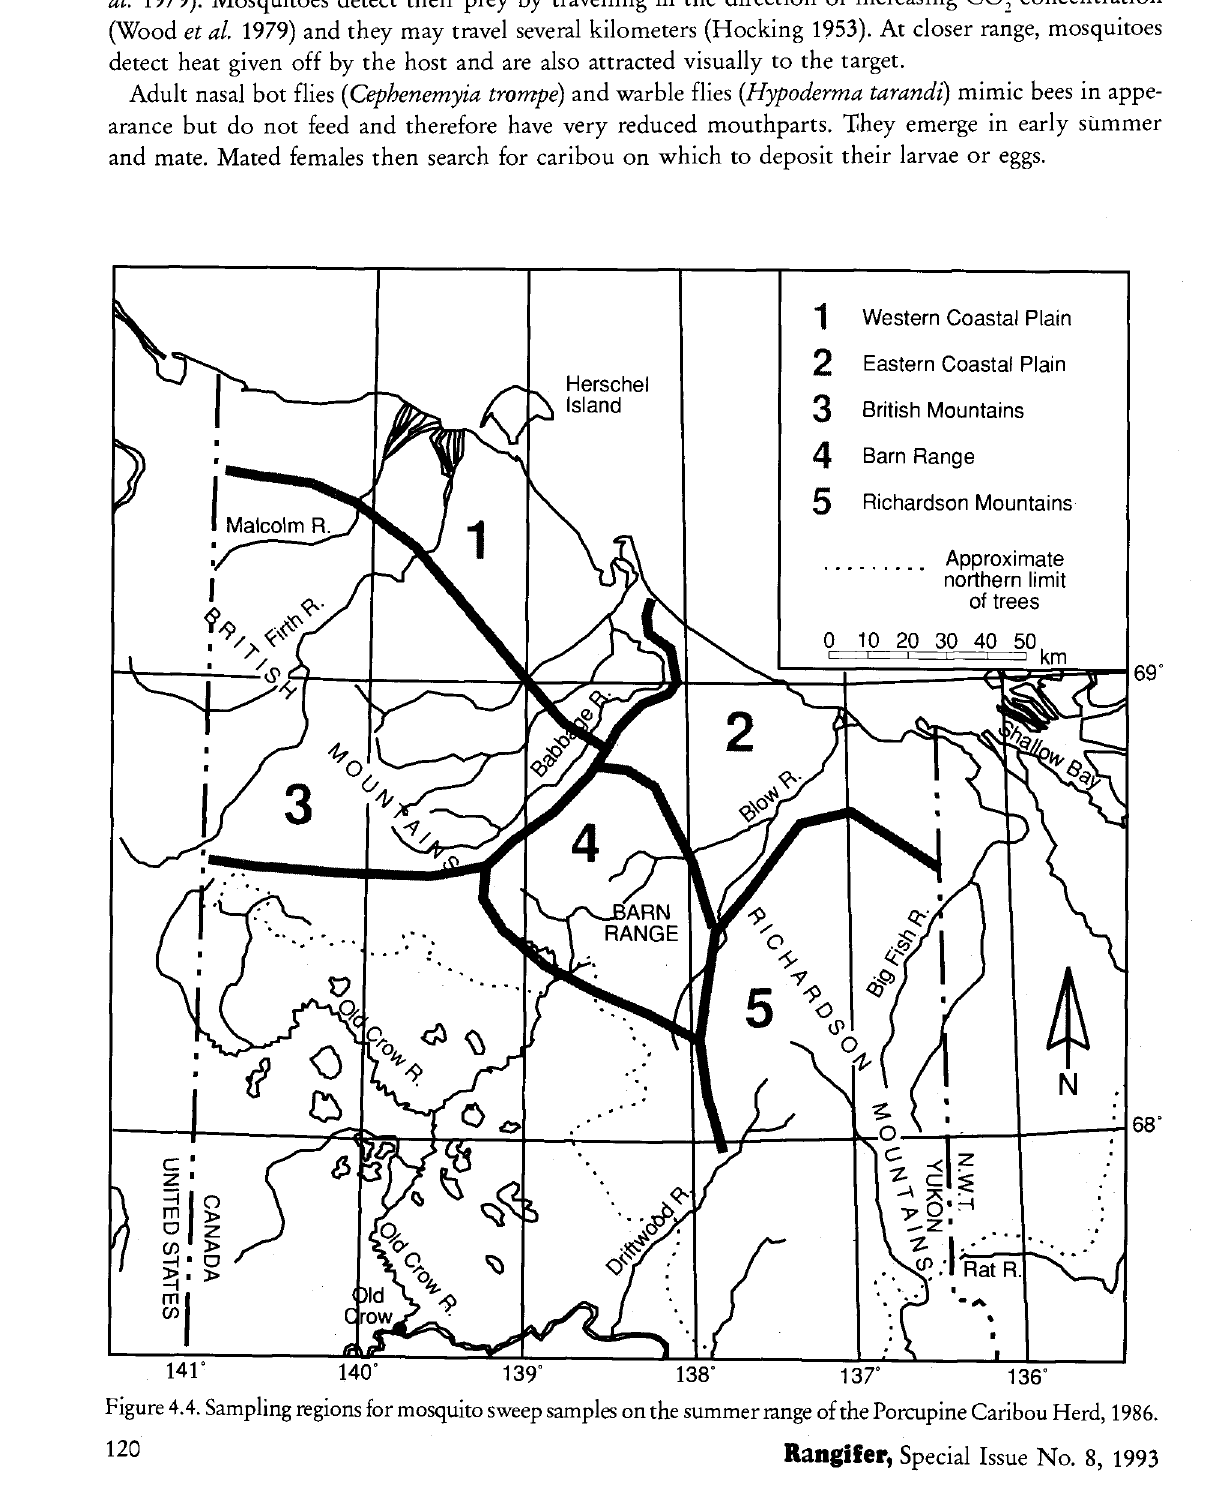
Figure 4.4. Sampling regions for mosquito sweep samples on the summer range of the Porcupine Caribou Herd,